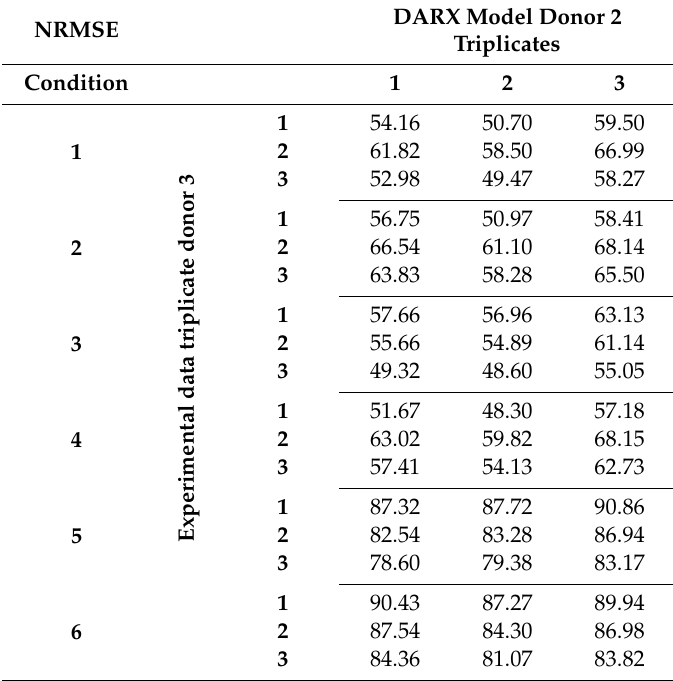
Table A1. Model mismatch example, where the DARX models of donor 2 are applied to experimental data from donor 3. The results are the NRMSE multiplied by 100, between the DARX model and the